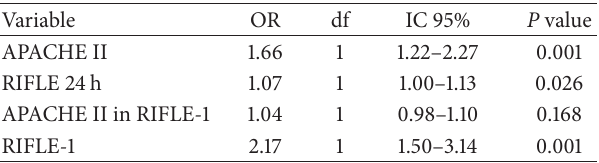
Figure 1: Frequency of mortality according to the RIFLE classifica- tion. Table 3: The Impact of the RIFLE classification criterion in ICU mortality, adjusted for APACHE II